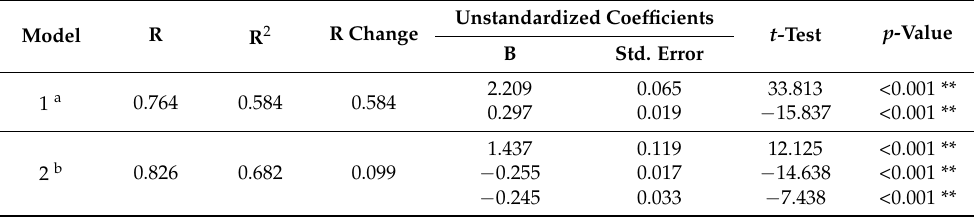
Table 5. Results of regression analysis (stepwise regression) for burnout